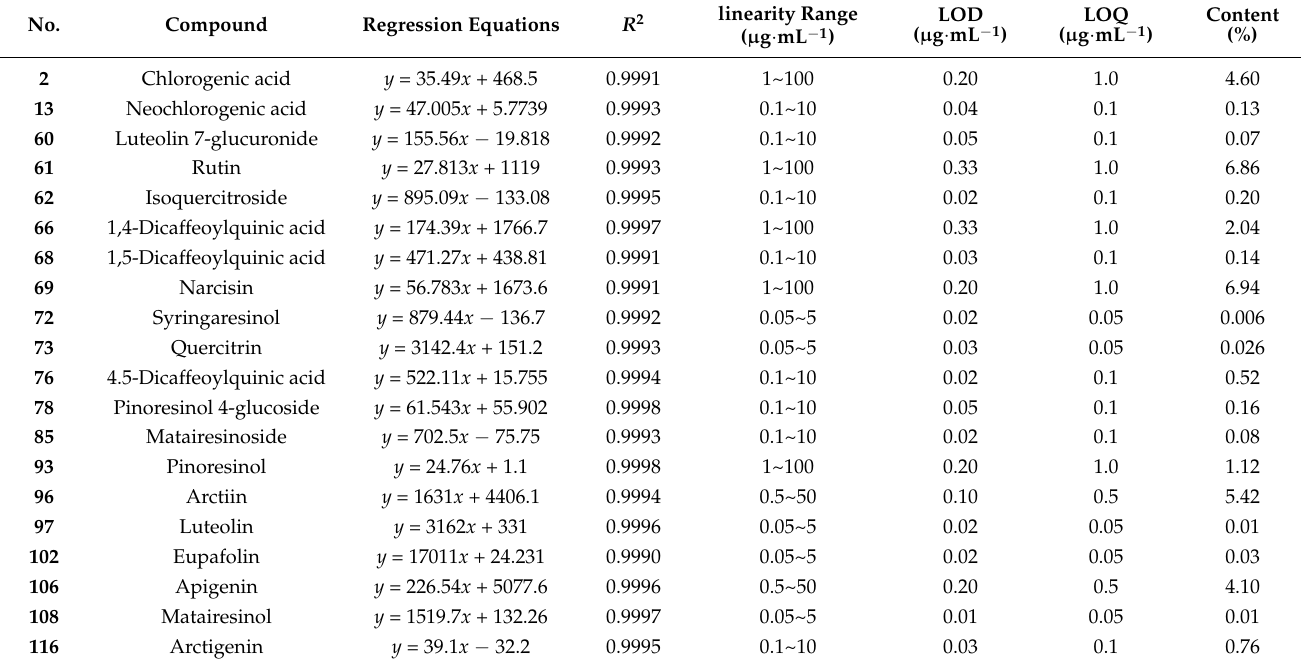
Table 2. Contents of 20 polyphenols in ethanol extract of